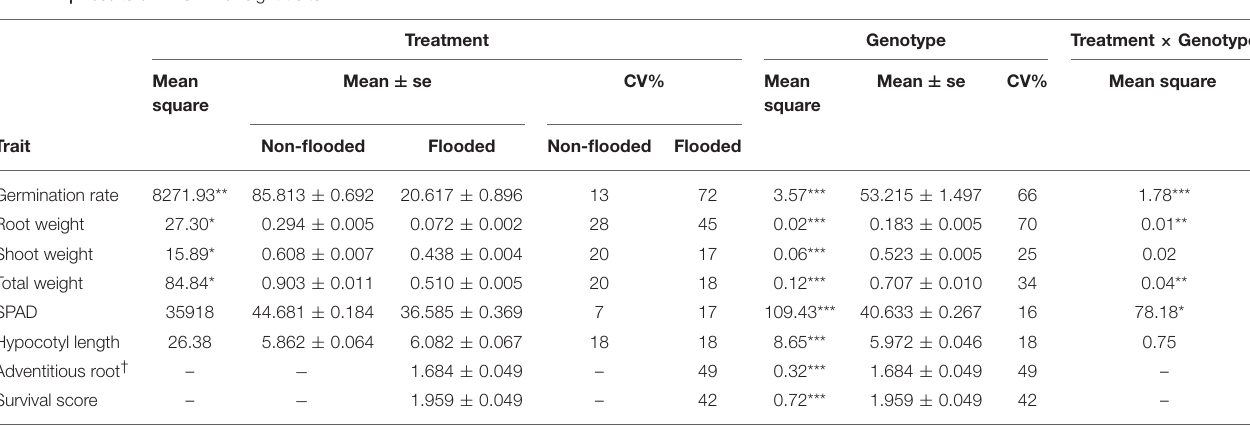
TABLE 1 | Results of ANOVA for eight